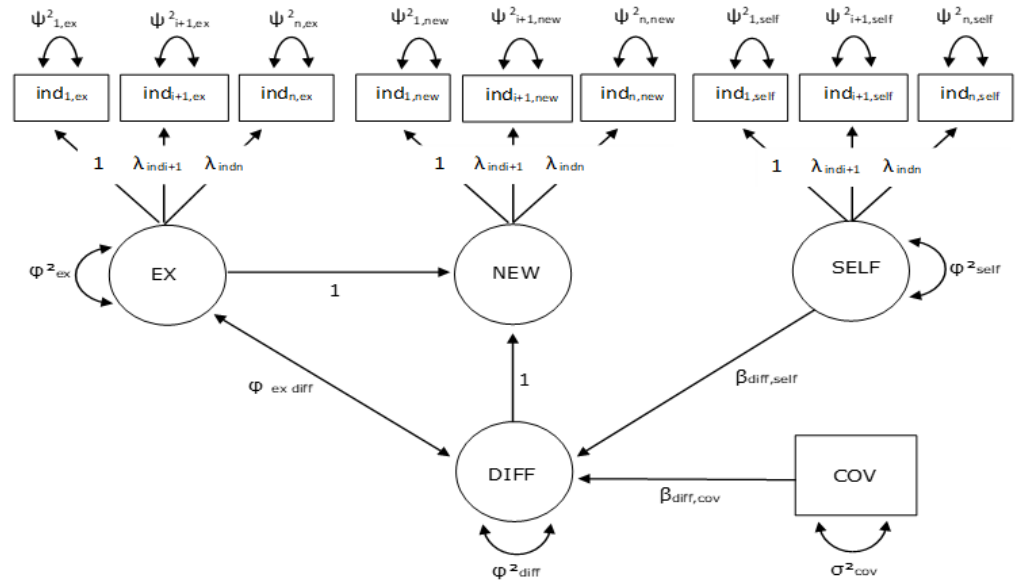
Figure 1. Multiple indicator latent difference score models (McArdle 2009), measured separately for each of the Big Five traits. Scalar measurement invariance was imposed. The latent difference score between the ex-spouse’s and new partner’s personality were regressed onto the personality of the shared partner (i.e., self) and the socio-demographic characteristics of the self and control variates (i.e., cov). Mean structures are not illustrated.